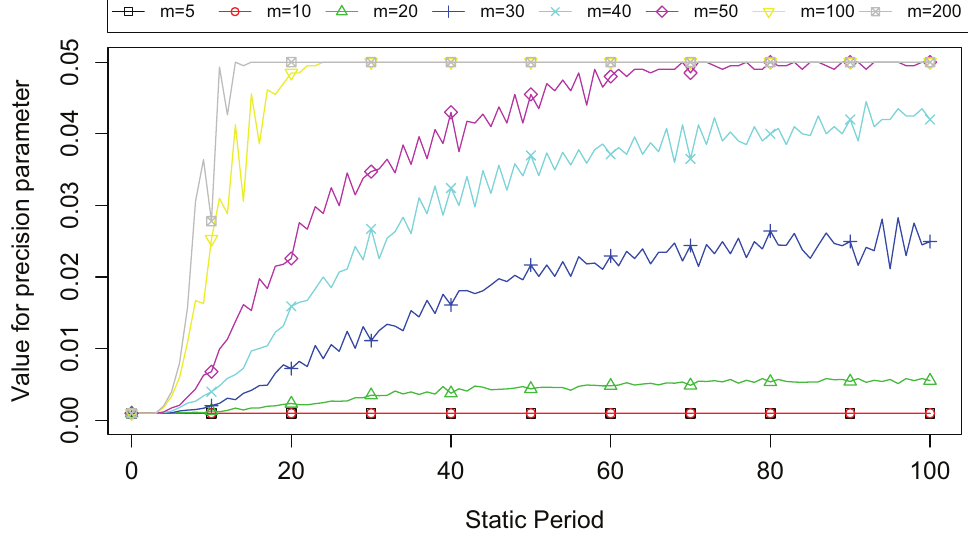
Fig. 5. Evolution of the adjustment of the parameter δ min along the search process depending on the number of peaks ( m ) of the MPB configuration. The x -axis represents the static period of the objec- tive function and the y -axis depicts the value for this parameter. The series indicate the corresponding MPB